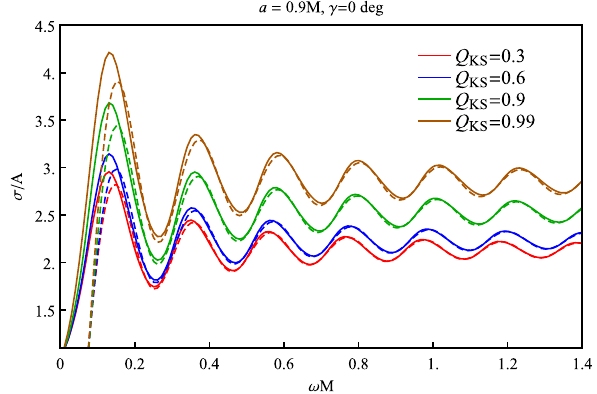
Fig. 3 Sinc approximation for the on-axis ( γ = 0) case. The solid lines are the numerically computed absorption cross sections and the dashed lines represent the sinc approximation